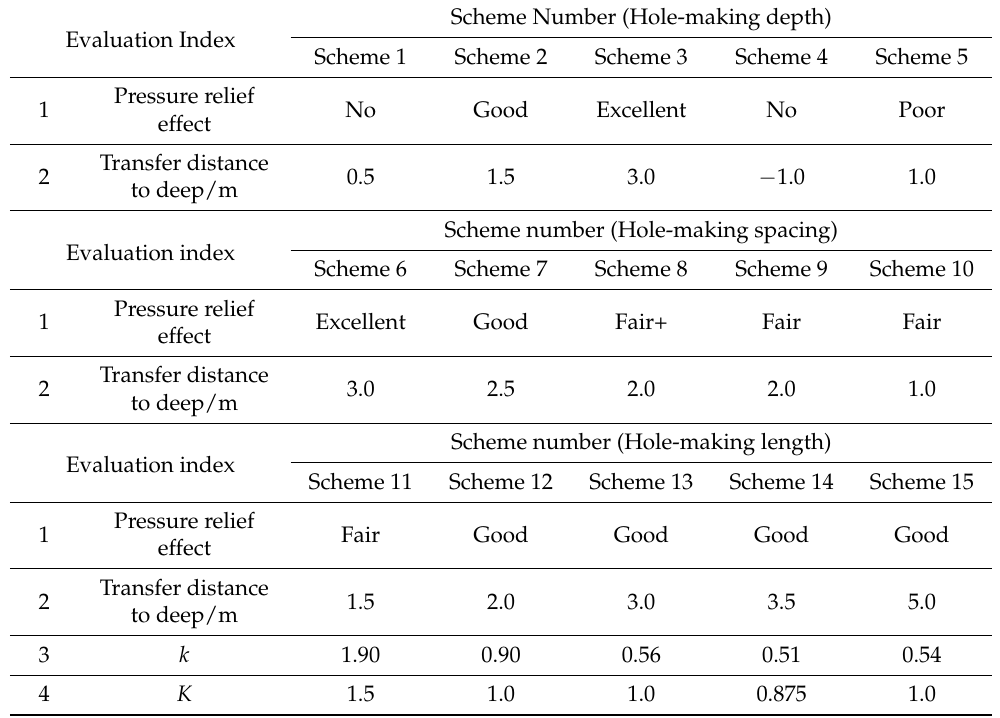
Table 3. Evaluation results of surrounding rock pressure relief for different hole-making